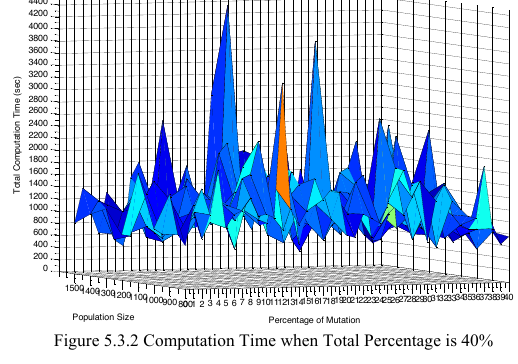
Figure 5.1.3 Computation Time for Population Size, 1,500 Figure 5.1 Total Percentage of Mutation and Crossover is 20% (Mutation over